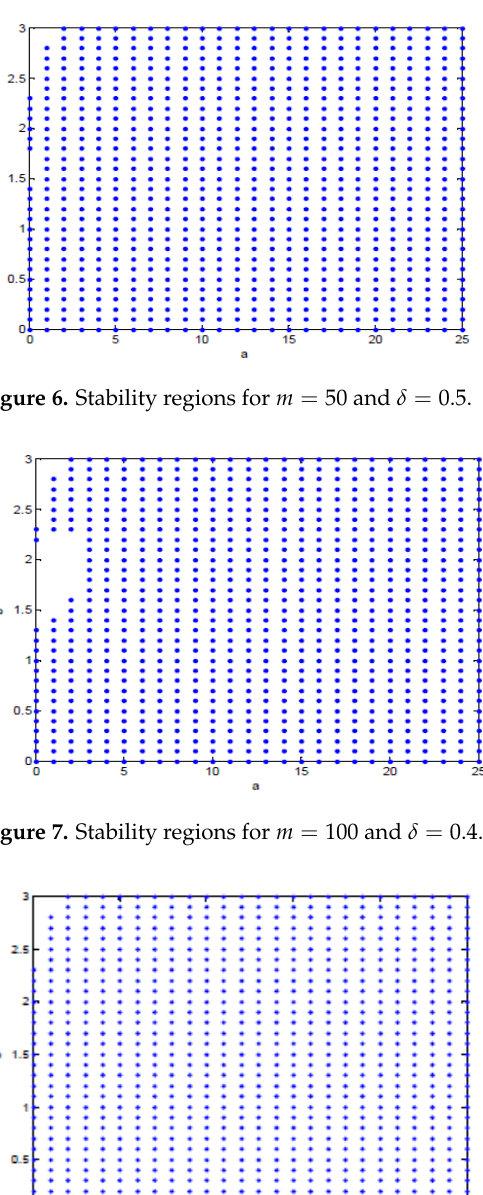
Figure 5. Stability regions for